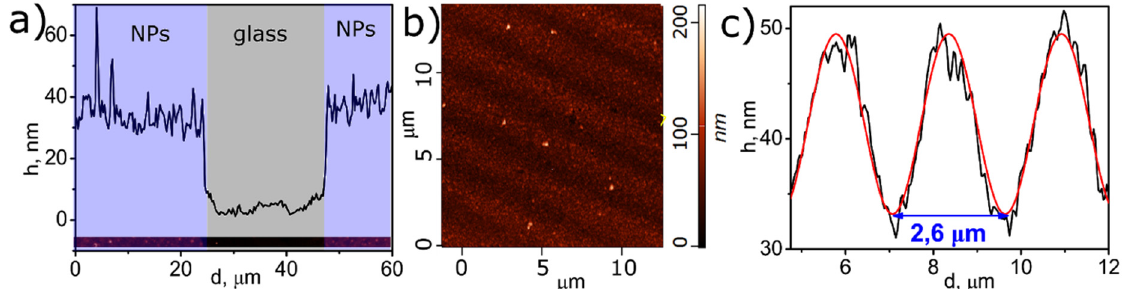
Figure 10. ( a ) AFM image and average profile of LID-synthesized sample; ( b ) AFM image of Ag NPs grating deposited under laser beam with interference pattern 375 lines/mm; ( c ) average profile (black line) and fitting waveform (red line) of synthesized periodic structure.